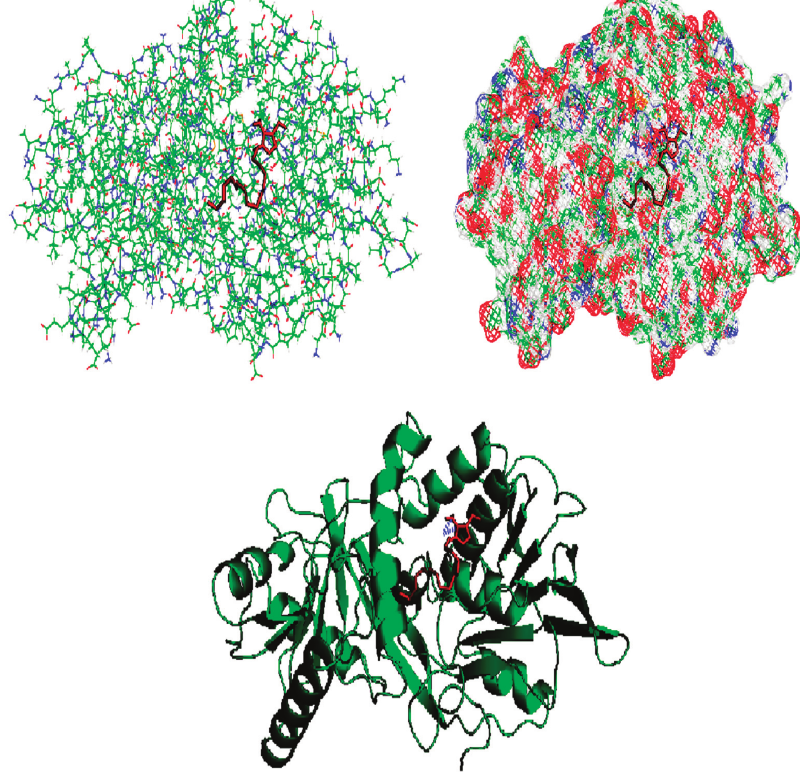
Figure 8: Three-dimensional plot of interaction of triazole ligand with P. vulgaris (5i39)